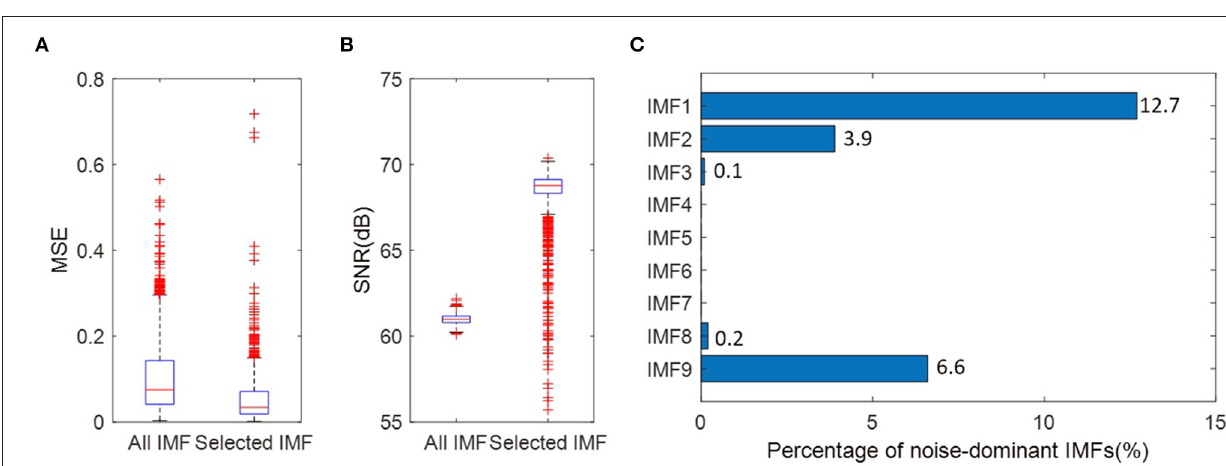
FIGURE 10 | (A) MSE between the reconstructed signals and the original signal. The reconstructed signals are obtained by all IMFs or selected IMFs, respectively. (B) SNR between the reconstructed signals and the original signal. (C) The percentage of noise-dominant IMFs at the “PF1” electrode for 1,373